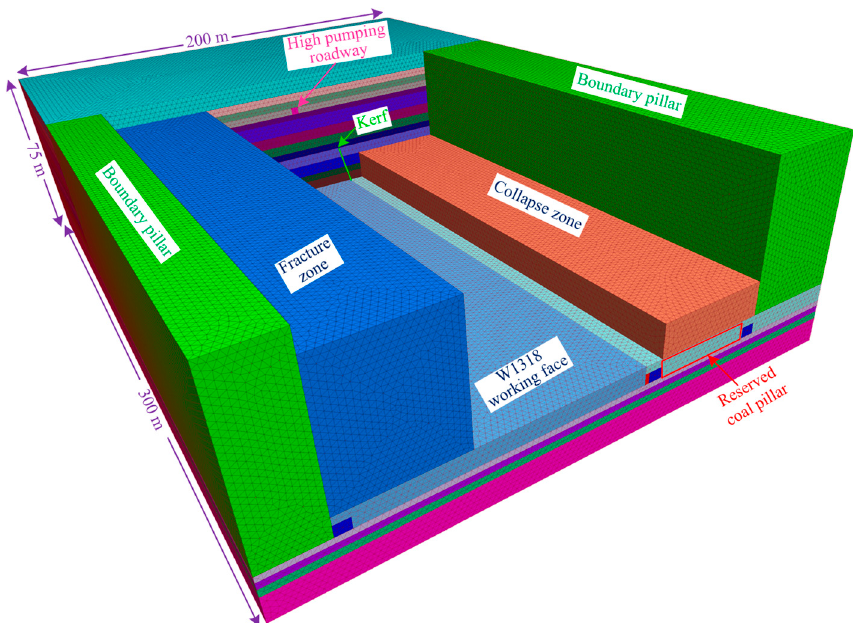
Figure 6. Numerical simulation model.